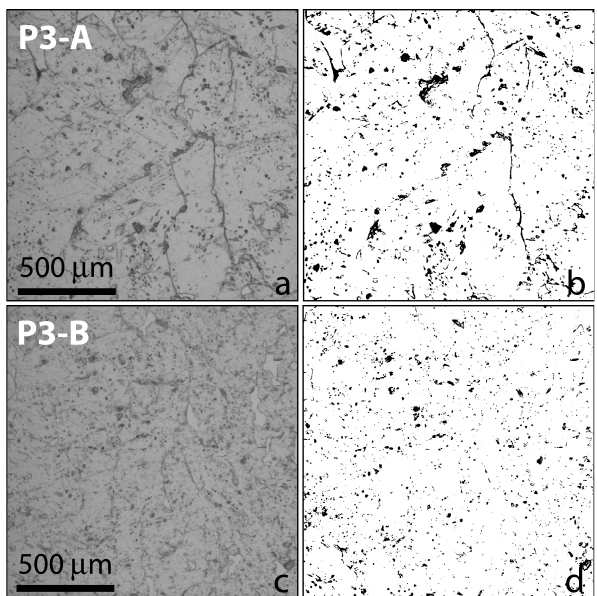
Fig. 4. Examples of microphotographs of stalagmite thin sections P3-A (a) and P3-B (c) characterized by higher and lower water yields, respectively. Also shown are their respective processed black and white images (b, d) , in which inclusions at the thin sections’ surface are visible as black pixels. Images (b) (P3-A) and (d) (P3- B) show 6.8% and 4.3% of black pixels, respectively. Note that these numbers do refer to the actual shown microphotographs and can deviate from the mean volume fractions of fluid inclusions given in Sect. 3.2, which average over 8 to 16 individual images.